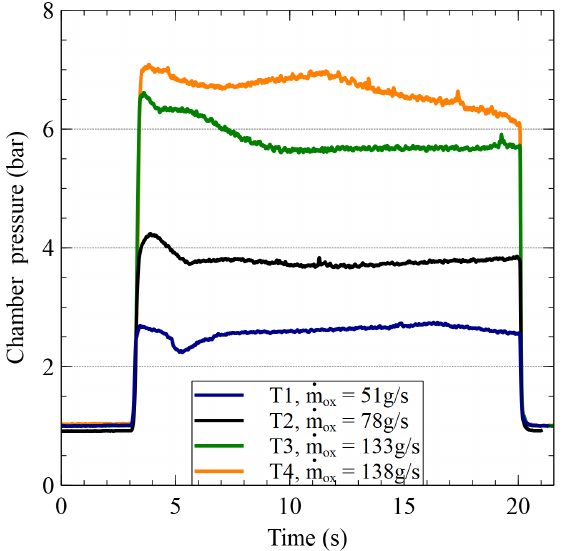
Figure 8. Open-loop test with constant oxidizer flow